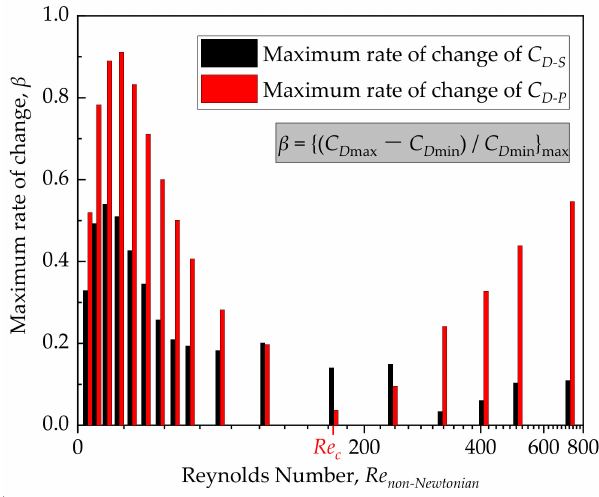
Figure 11. Relationship between the maximum drag force coefficient rate of change ( β ) and Re non-Newtonian considering different H .